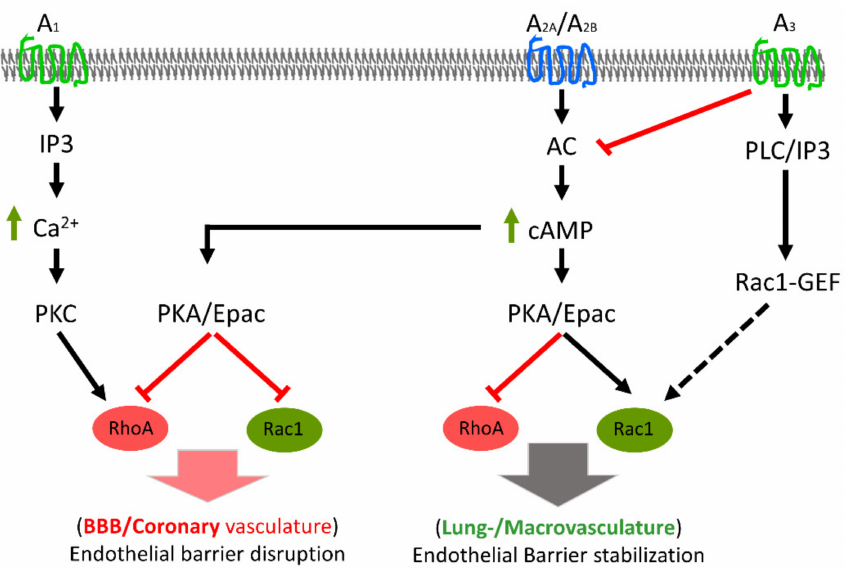
Figure 2. Key mechanisms involved in adenosine receptors-mediated endothelial barrier regulation. In lung microvasculature and macrovascular endothelium, A 2 receptor activation causes an activation of Rac1 and an inhibition of RhoA, leading to stabilisation of the endothelial barrier. On the other hand, in coronary microvascular ECs, inhibition of both RhoA and Rac1 results in disruption of endothelial cytoskeleton and barrier failure. Black arrows indicate sequence of signal transduction, broken arrow indicates involvement of multiple steps in between, and green arrows indicate increase in cellular levels of indicated second messenger. Red bocks mean inhibition. AC: adenylyl